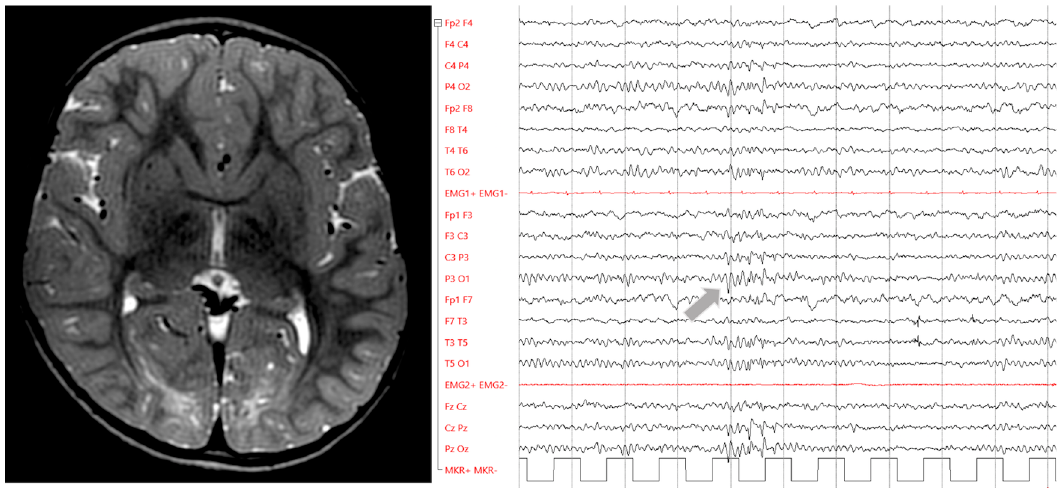
Figure 3. Brain MRI and EEG in focal symptomatic epilepsy in perinatal hypoglycaemia. Axial FLAIR 1.5T brain MRI ( left ) depicts bilateral symmetrical hyperintensity of the occipital white matter in a 12-year-old child who suffered recurrent convulsive seizures during neonatal hypoglycaemia and still exhibits drug-resistant focal impaired awareness seizures with staring, sialorrhea and left eye/head deviation. EEG recording (10–20 International System) ( right ) display sharp waves in a burst over the posterior brain areas, predominating on the left parieto–occipital region